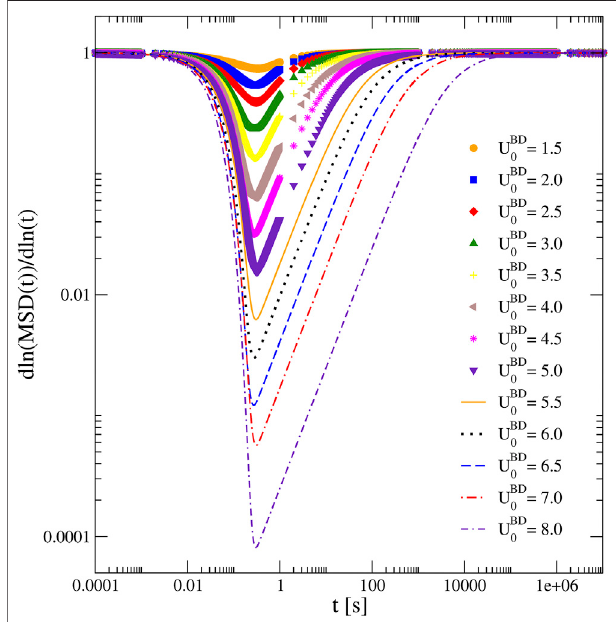
FIGURE 8 | (Color online): Logarithmic derivative of the mean square displacement MSD(t) ofasphericaltracer asa function oftime in thepresence of a periodic cosine-like potential of amplitude U 0 . Solid symbols correspond to Brownian dynamics simulations in which L (cid:2) 1 . 0 × 10 − 6 m and D BD 0